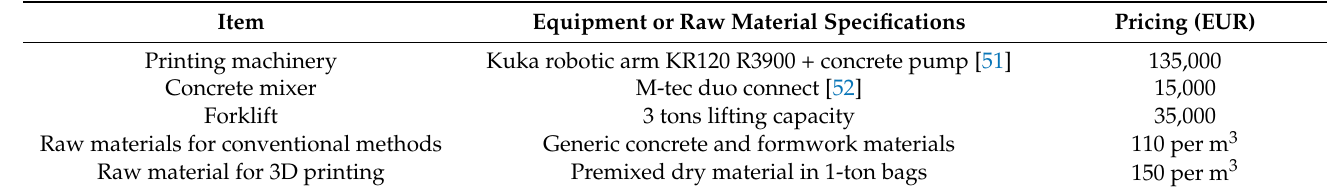
Table 2. Project component specifications.